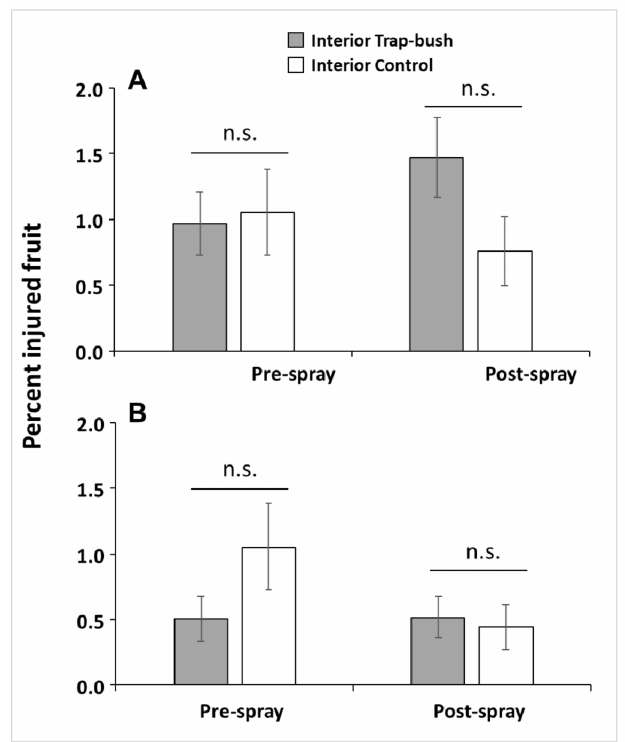
Figure 5. Percent (mean ± SE) of oviposition-scarred fruit by Conotrachelus nenuphar adults in interior trees within plots containing odor-baited trap bushes (trap-tree plots) or unbaited bushes (control plots) in 2013 ( A ) and 2014 ( B ). Fruit injury was assessed before and after a post-bloom insecticide application. n.s. = no significant di ff erences according to Welch’s two-sample t -test ( p >